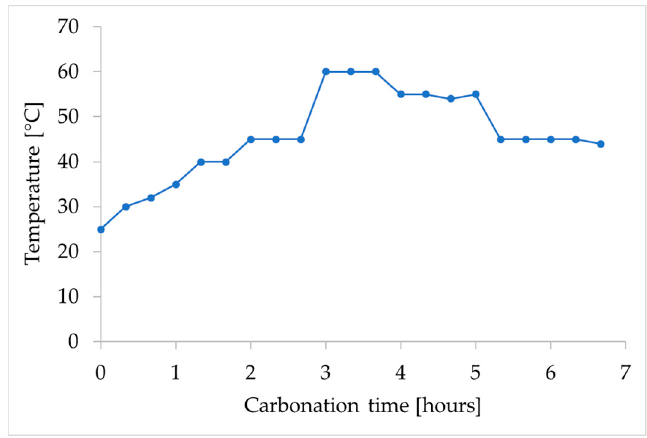
Figure 5. Temperature profile in carbonation chamber at 3 bar CO 2 pressure.